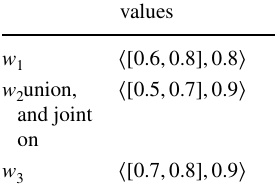
Table 7 The allocation of cubic fuzzy values to the branches of bank A